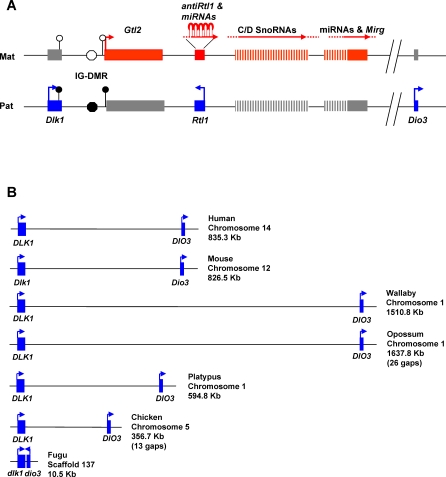

Dlk1-Dio3 in Vertebrates(A) Schematic representation of the Dlk1-Dio3 domain in mouse showing genes expressed from the paternal chromosome (blue) and noncoding RNAs (red) expressed from the maternally inherited chromosome. The imprinting control region for the domain is the paternally methylated IG-DMR (circle). Also shown are differentially methylated regions in exon 5 of Dlk1 and the promoter region of Gtl2. Filled circles, methylated; open circlesn unmethylated. Not drawn to scale.(B) The relative positions of DLK1 and DIO3 in vertebrates. The domain sizes were calculated from the start codon of DLK1 to the stop codon of DIO3. (Genome builds were human March 2006, mouse February 2006, opossum January 2006, chicken May 2006, and fugu October 2004).